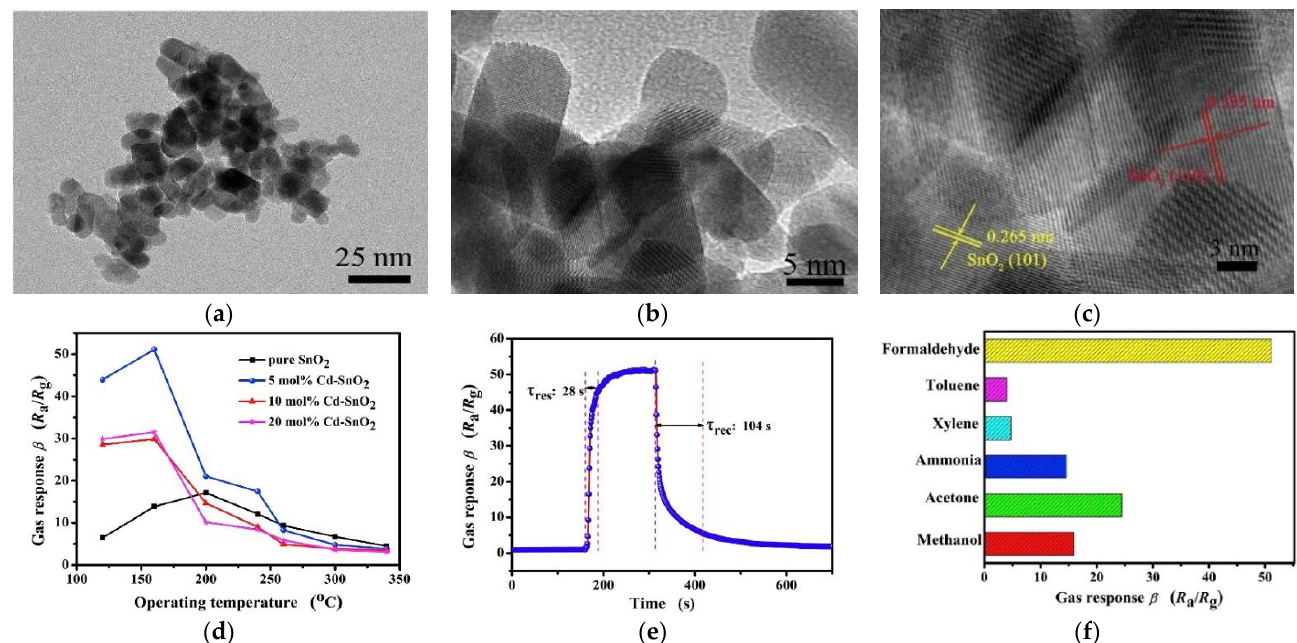
Figure 2. ( a ) TEM image and ( b , c ) HRTEM images of 5 mol% Cd-doped SnO 2 nanofibers prepared by shaddock peels as bio-templates; ( d ) gas responses of the sensors based on different Cd-doped SnO 2 nanofibers toward 100 ppm formaldehyde at various operating temperature; ( e ) response-recovery curve of the sensor towards 100 ppm formaldehyde at the operating temperature of 160 °C; ( f ) gas responses of the 5 mol% Cd-doped SnO 2 nanofibers based sensor towards 100 ppm different volatile organic compounds gases at 160 °C [43].